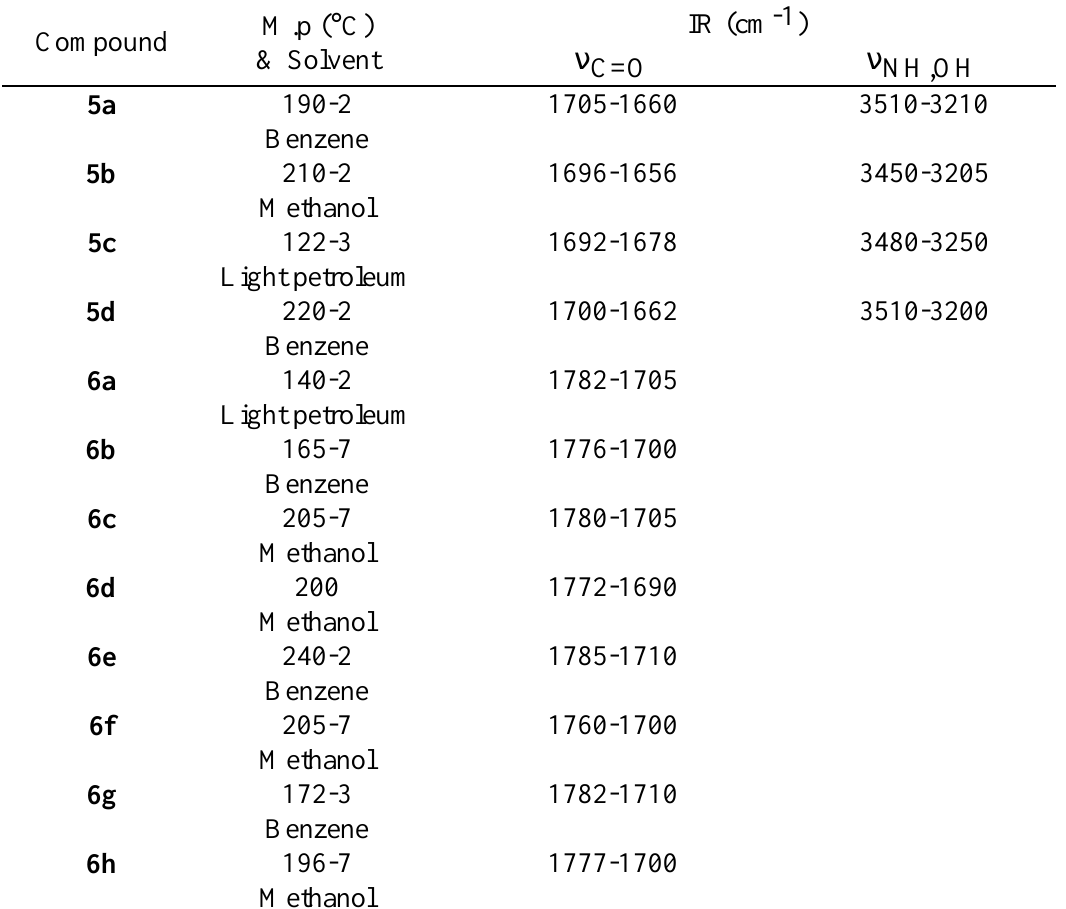
Table 2. Physical data of hydrazide derivatives 5a - d and 1,4-oxazine derivatives 6a - h